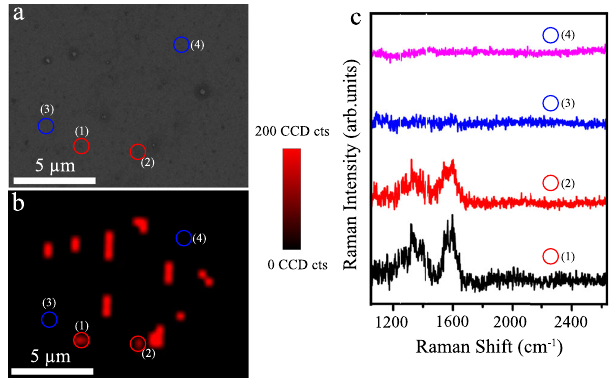
Fig. 2 Demonstration of the single-particle SERS activity of DTNB- labelled nanoboxes. a SEM image and b corresponding SERS mapping image of DTNB-labelled nanoboxes on a silicon substrate; c representative SERS spectra of numbered locations indicated in a and b . The red dotted line shows the characteristic peak at 1330 cm − 1 from DTNB. Data from one independent experiment. Source data are provided in the Source Data fi le.